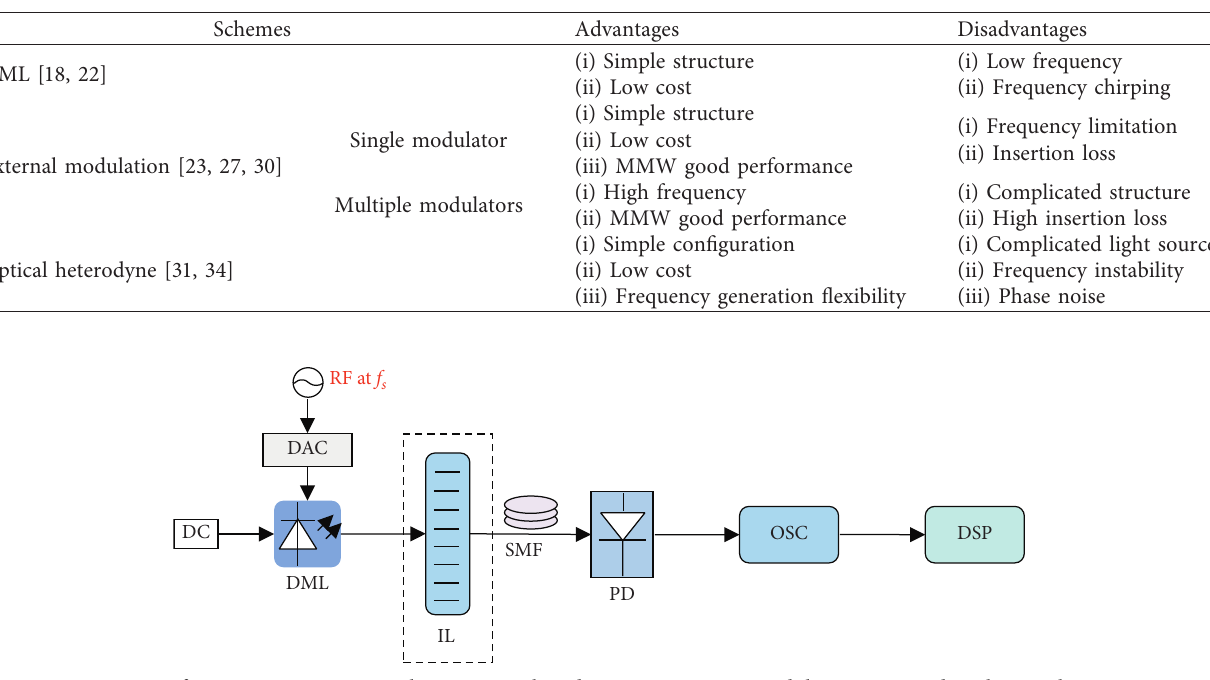
Figure 5: Diagram of vector mm-wave signal generation based on SSB or DSB modulation. DAC, digital-to-analog converter; IL, interleaver; SMF, single mode fiber; OSC, oscilloscope.